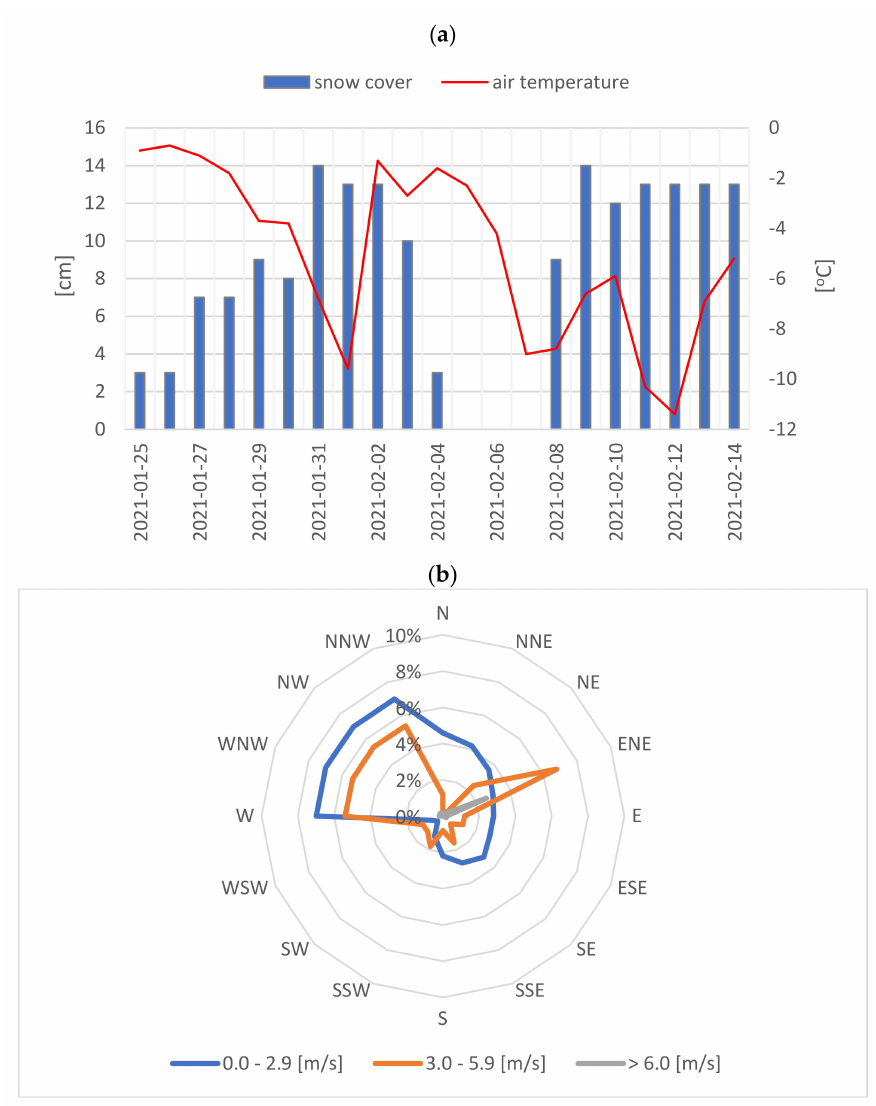
Figure 2. Meteorological conditions: ( a ) air temperature and snow cover depth, ( b ) wind speed and direction during the snow cover research (data from the Institute of Meteorology and Water Management in Kielce–Suk ó